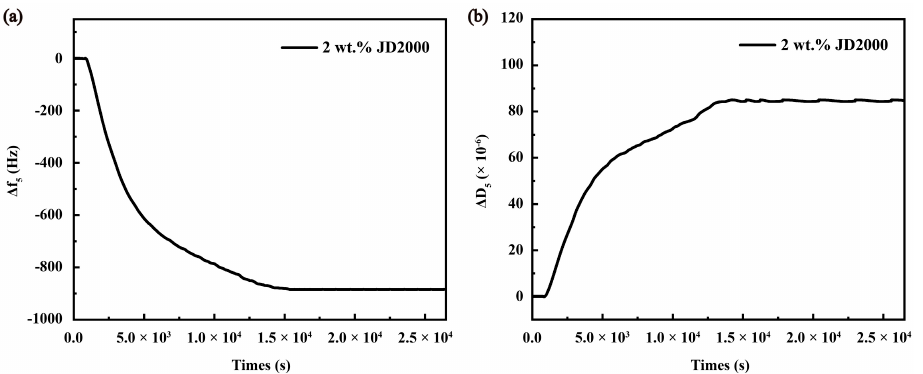
Figure 12. ( a ) Frequency variation curve and ( b ) energy dissipation factor variation curve of the 2 wt.% JD2000 aqueous solution on the metal